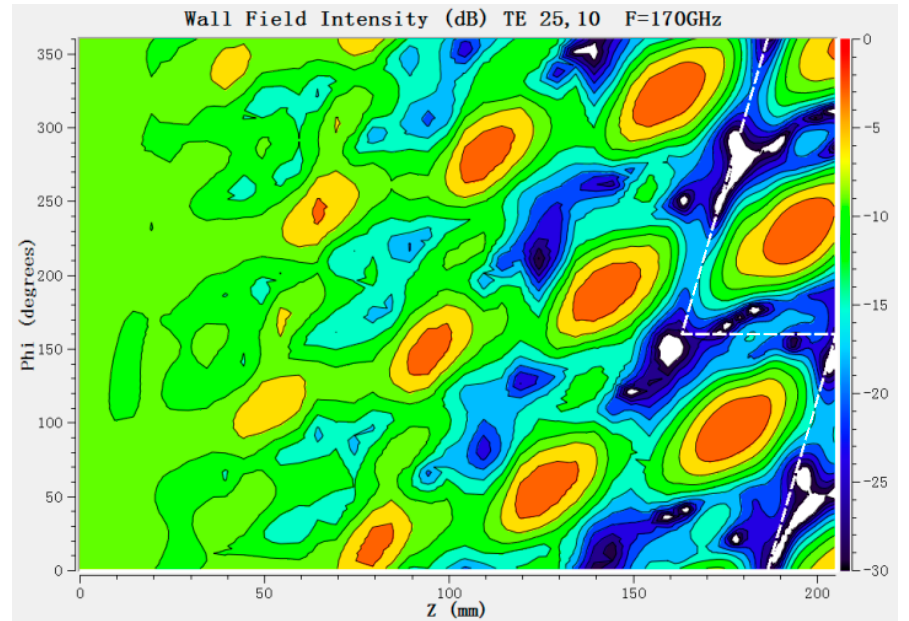
Figure 10. Field distribution on the unfolded launcher wall. The white dotted lines denote the edges of the cuts.